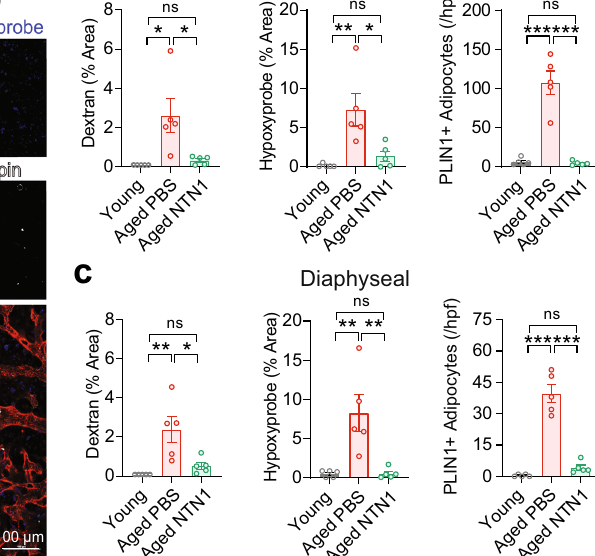
both trabecular b , and diaphyseal c regions of femoral BM, as compared to young controls ( N =5 mice/group). Data is presented as the mean ± standard error of the mean (SEM). Statistical signi fi cance determined using One-Way ANOVA with Tukey ’ s correction for multiple comparisons. * P <0.05; ** P <0.01; *** P <0.001. ns denotes statistically not signi fi